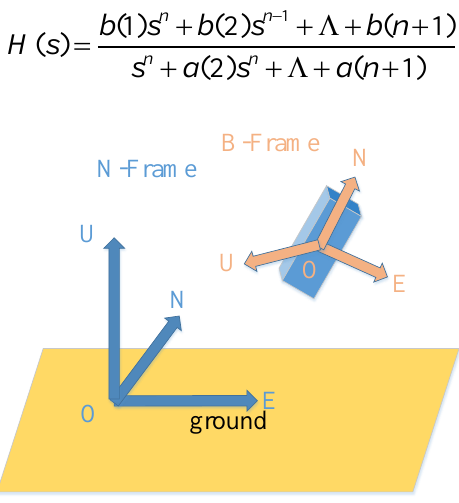
Figure 1. Illustration of the two coordinate